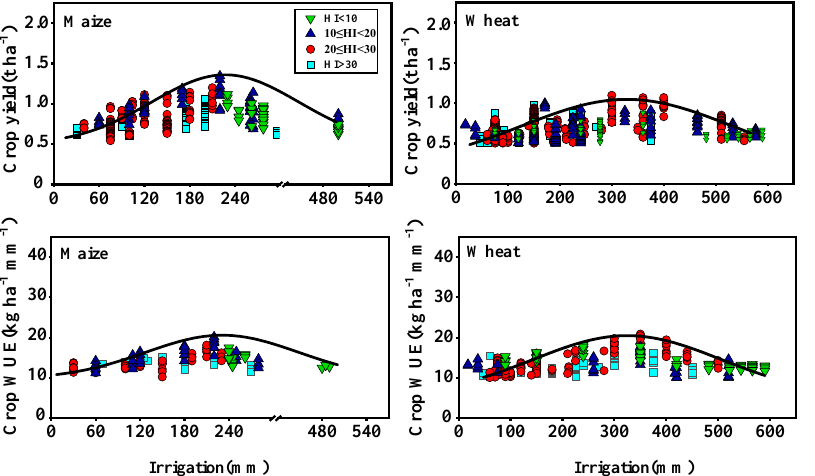
Figure 6. The crop yield and WUE according to irrigation (mm). The solid lines are fitted by non-linear regression model to yield and WUE datasets of maize and wheat. Triangles represent field experiment of maize and squares represent field experiment of wheat. The color of symbol represents HI.